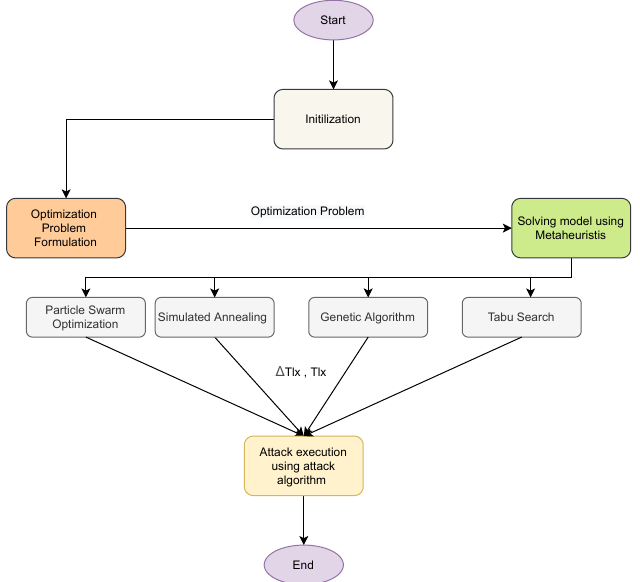
Figure 4. Flowchart of the Attack